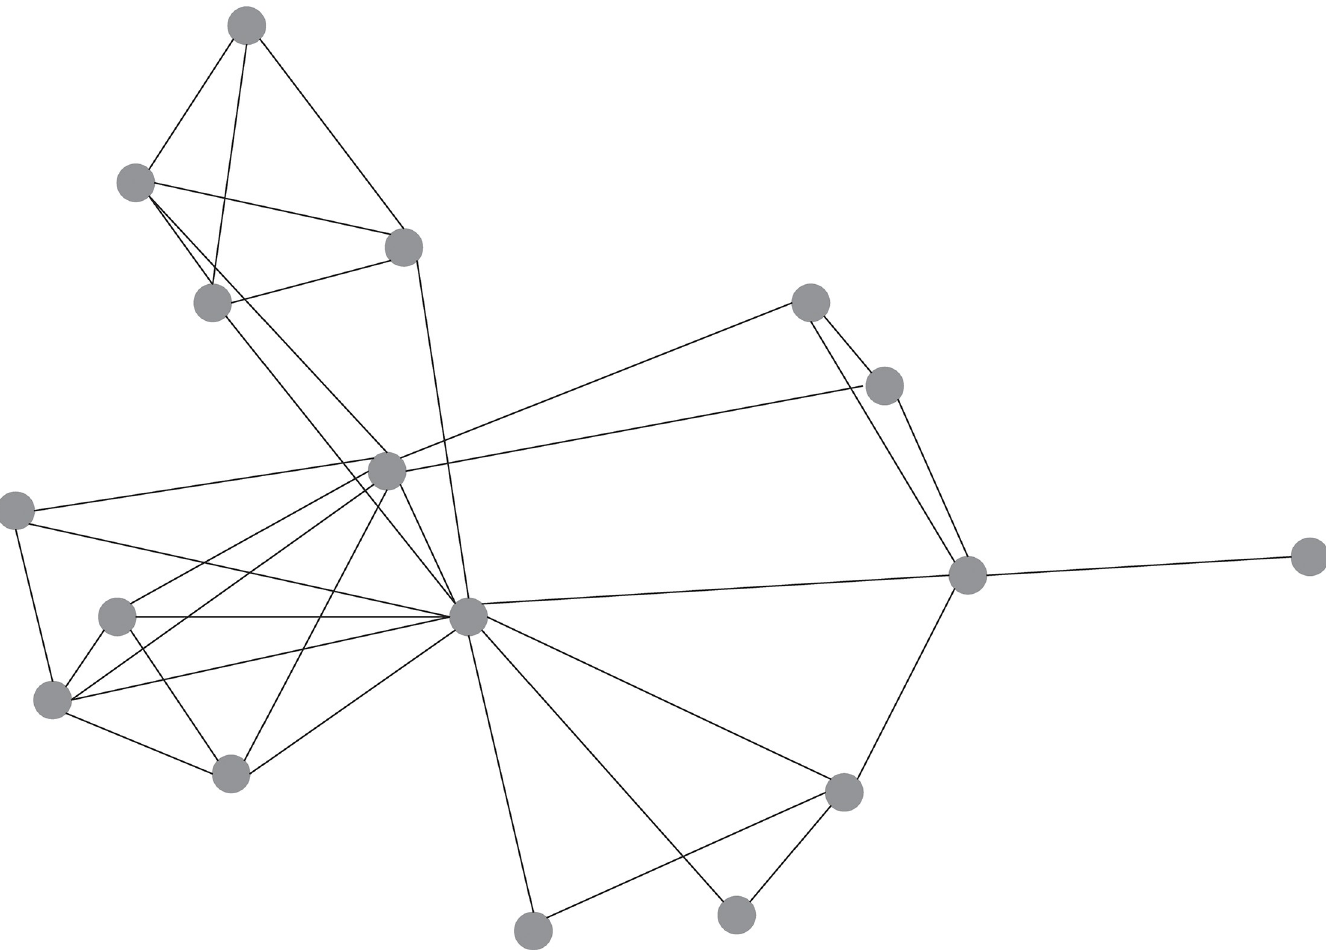
Fig 2. Sociogram of a help network with low segmentation (value .33) and high inequality (value .21).